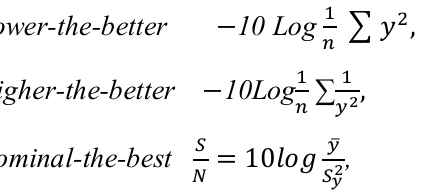
of Taguchi along with Assigned Value